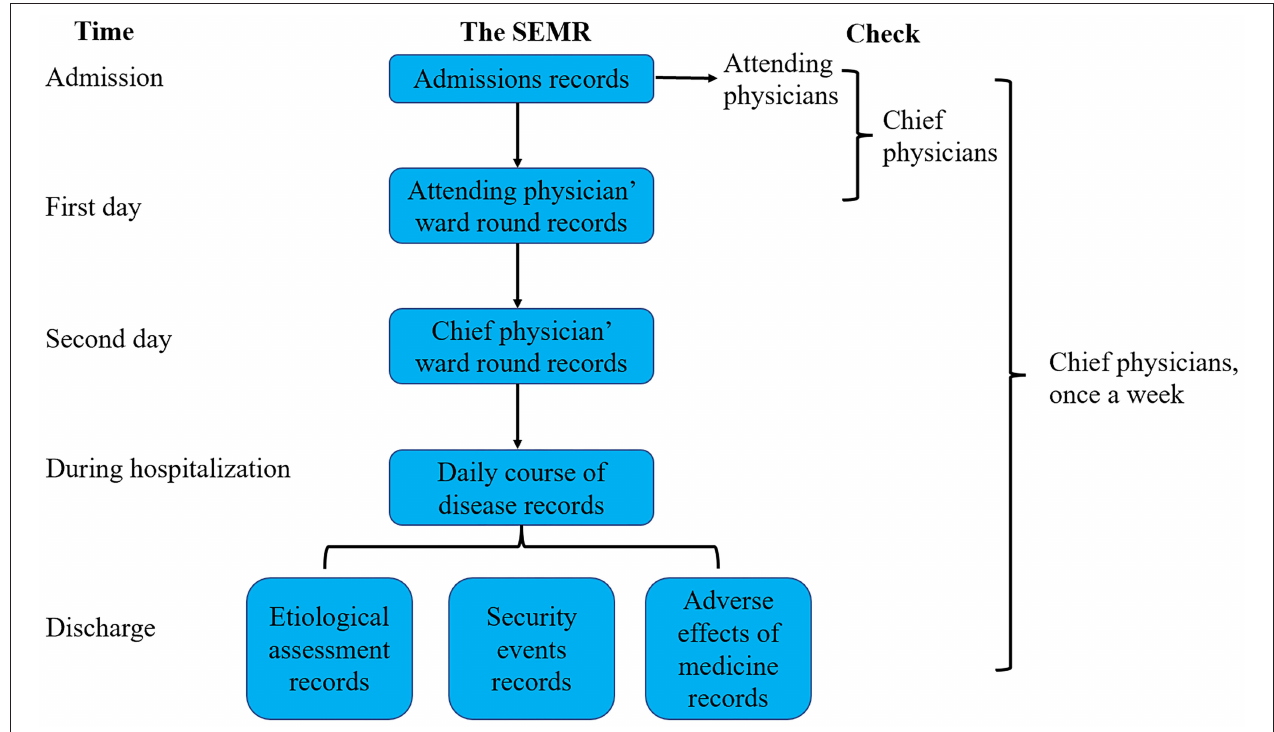
FIGURE 2 | The flow chart of the process of usage of the structured electronic medical